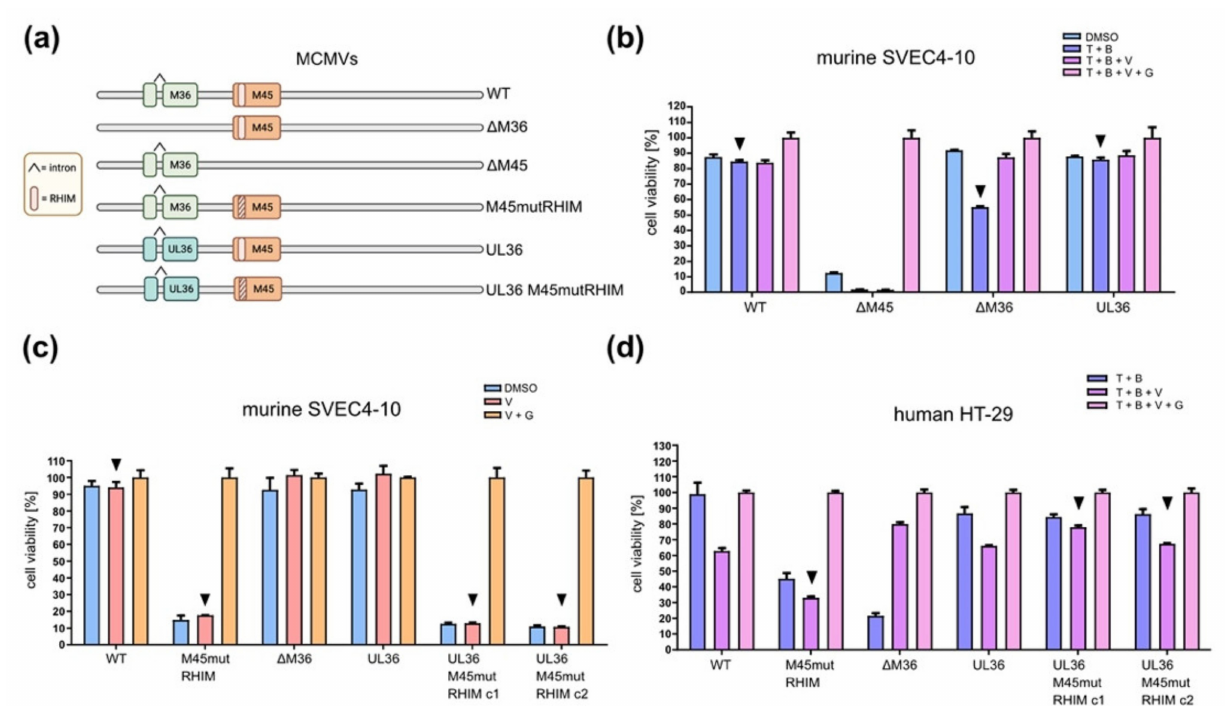
Figure 6. UL36 inhibits necroptosis in human but not in murine cells. ( a ) Schematic of MCMV mutants, generated with BioRender (accessed on September 1, 2021). ( b ) SVEC4-10 cells were infected with MCMVs (MOI 5) and treated 6 hpi with TNF α (T, 30 ng/mL), the SMAC mimetic BV6 (B, 1 µ M), the caspase inhibitor zVAD-fmk (V, 75 µ M), and the RIPK3 inhibitor GSK’872 (3 µ M). Cell viability was determined by measuring ATP levels at 24 hpi. Values were normalized by group to cells treated with both inhibitors (T+B+V+G). ( c ) SVEC4-10 cells were treated with a caspase inhibitor (zVAD-fmk, 50 µ M), a RIPK3 inhibitor (GSK’872, 5 µ M), or vector (DMSO, 0.1%), and infected 1 h post-treatment with MCMV mutants. Cell viability was determined by measuring ATP levels at 24 hpi. For MCMV-UL36-M45 mut RHIM two independent clones were used. Values were normalized by group to V+G treated cells ( d ) HT-29 cells were MCMVs infected and treated 6 hpi as in B. Cell viability was determined by measuring ATP levels at 24 hpi. Values were normalized by group to T+B+V+G-treated cells. For MCMV-UL36-M45 mut RHIM two independent clones were used. Arrowheads indicate the samples to be